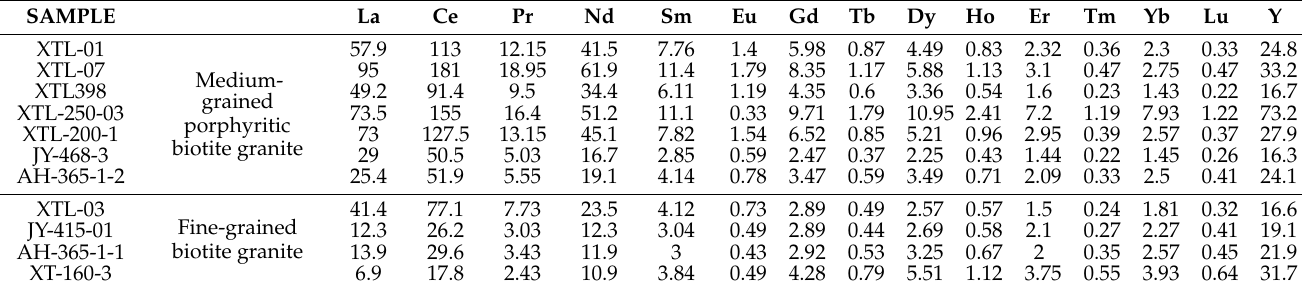
Table 3. Rare-earth element concentrations in granite in Xintianling ore field, Hunan (ppm).